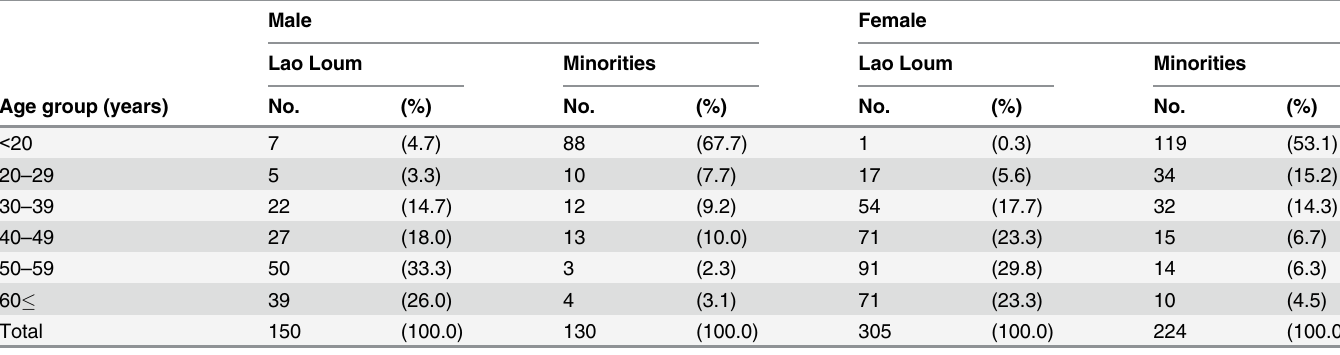
Table 1. Breakdown of participants by age and gender